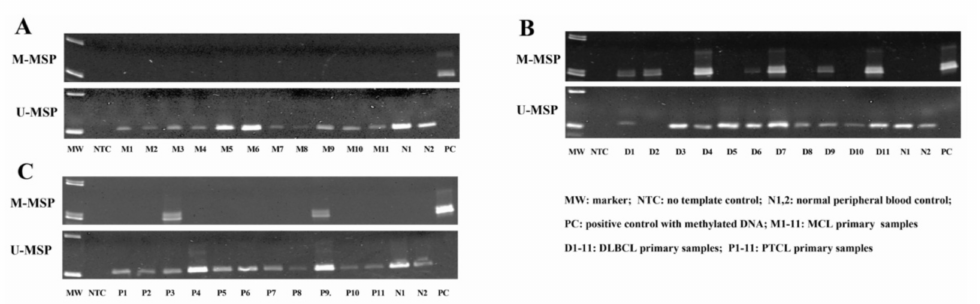
Figure 3. Methylation status of NKILA is demonstrated in different types of NHL primary samples by MSP. Representative M- and U-MSP shows the methylation of NKILA in MCL ( A ), DLBCL ( B ) and PTCL ( C